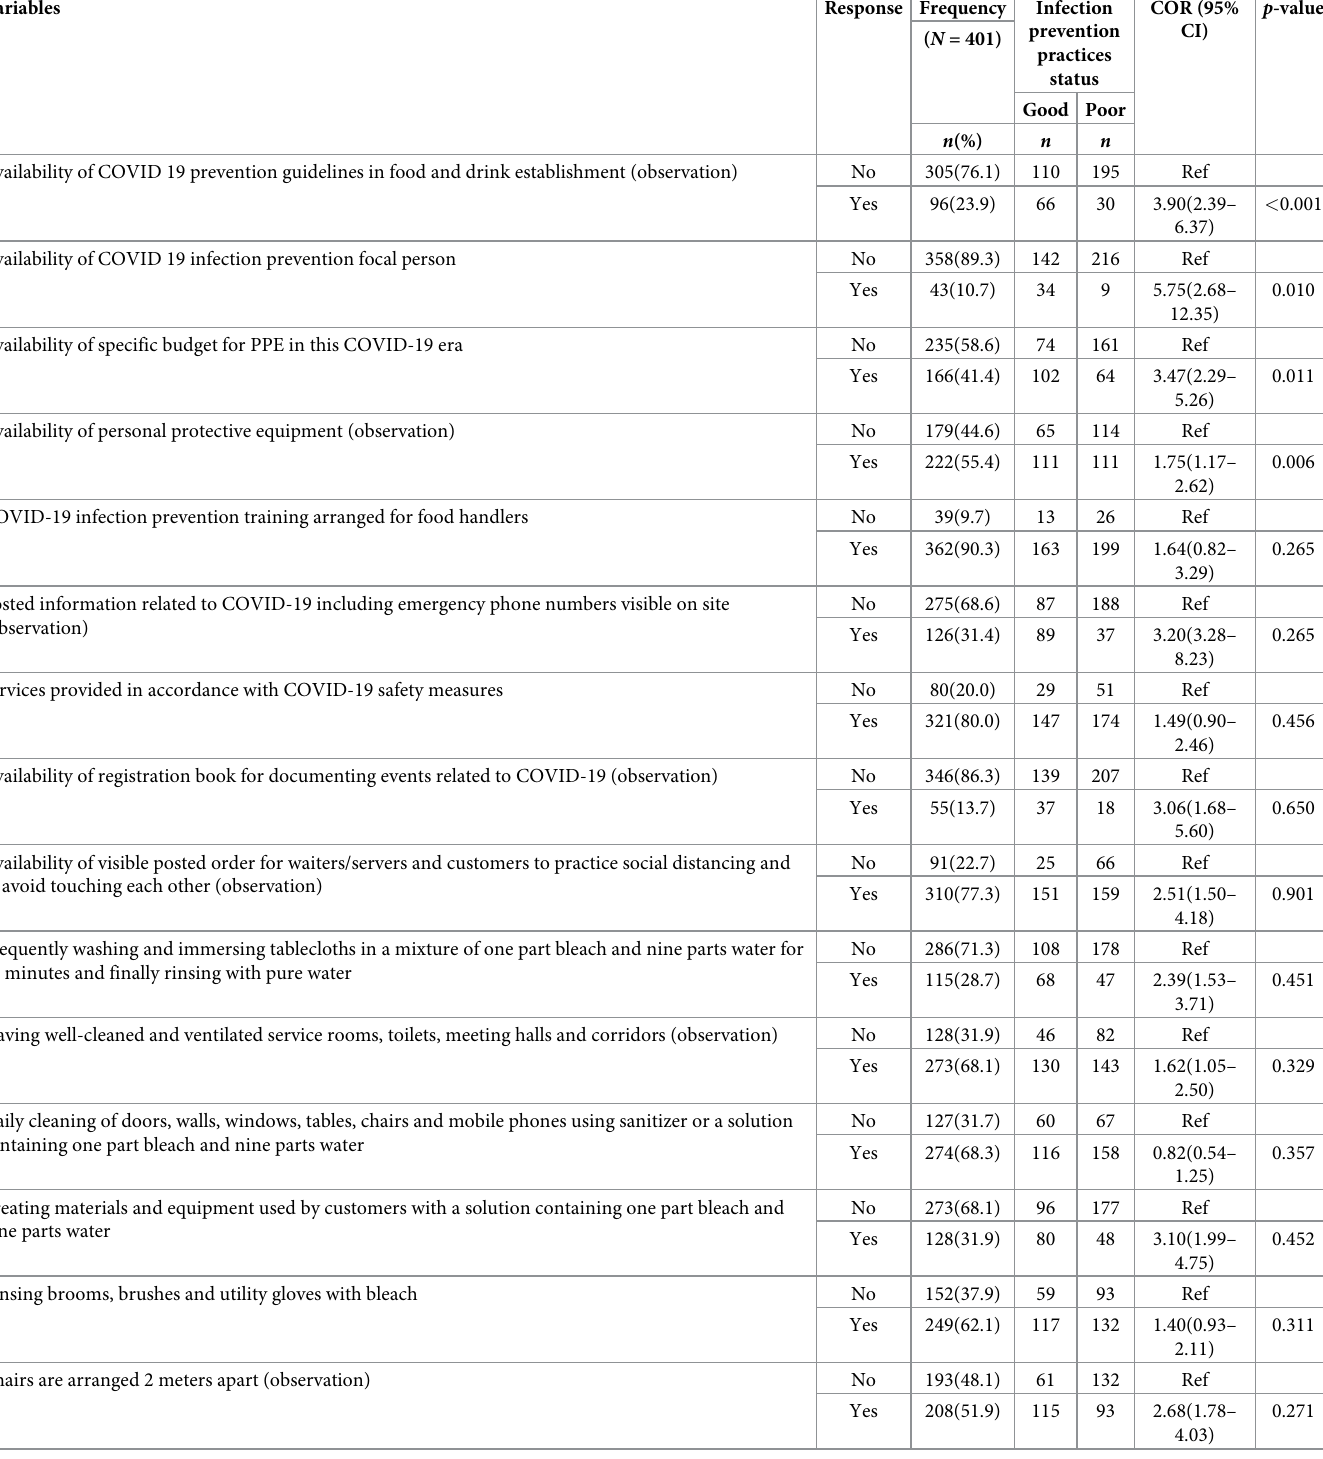
Table 2. Availability of supplies and its bivariable analysis with infection prevention practices among food handlers at food and drink establishments in Dessie City and Kombolcha Town, Northeastern Ethiopia, July–August 2020.